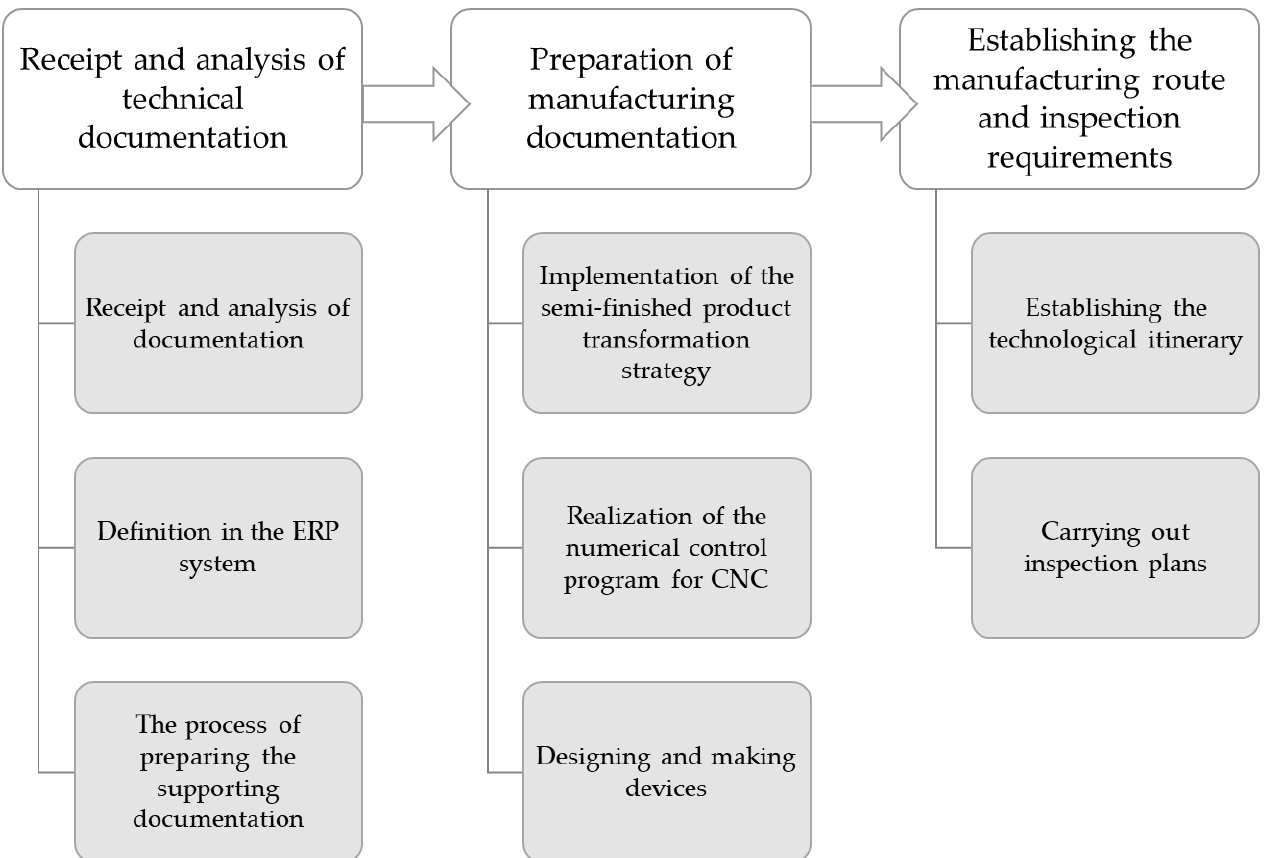
Figure 3. Grouping the component processes within the global engineering process.